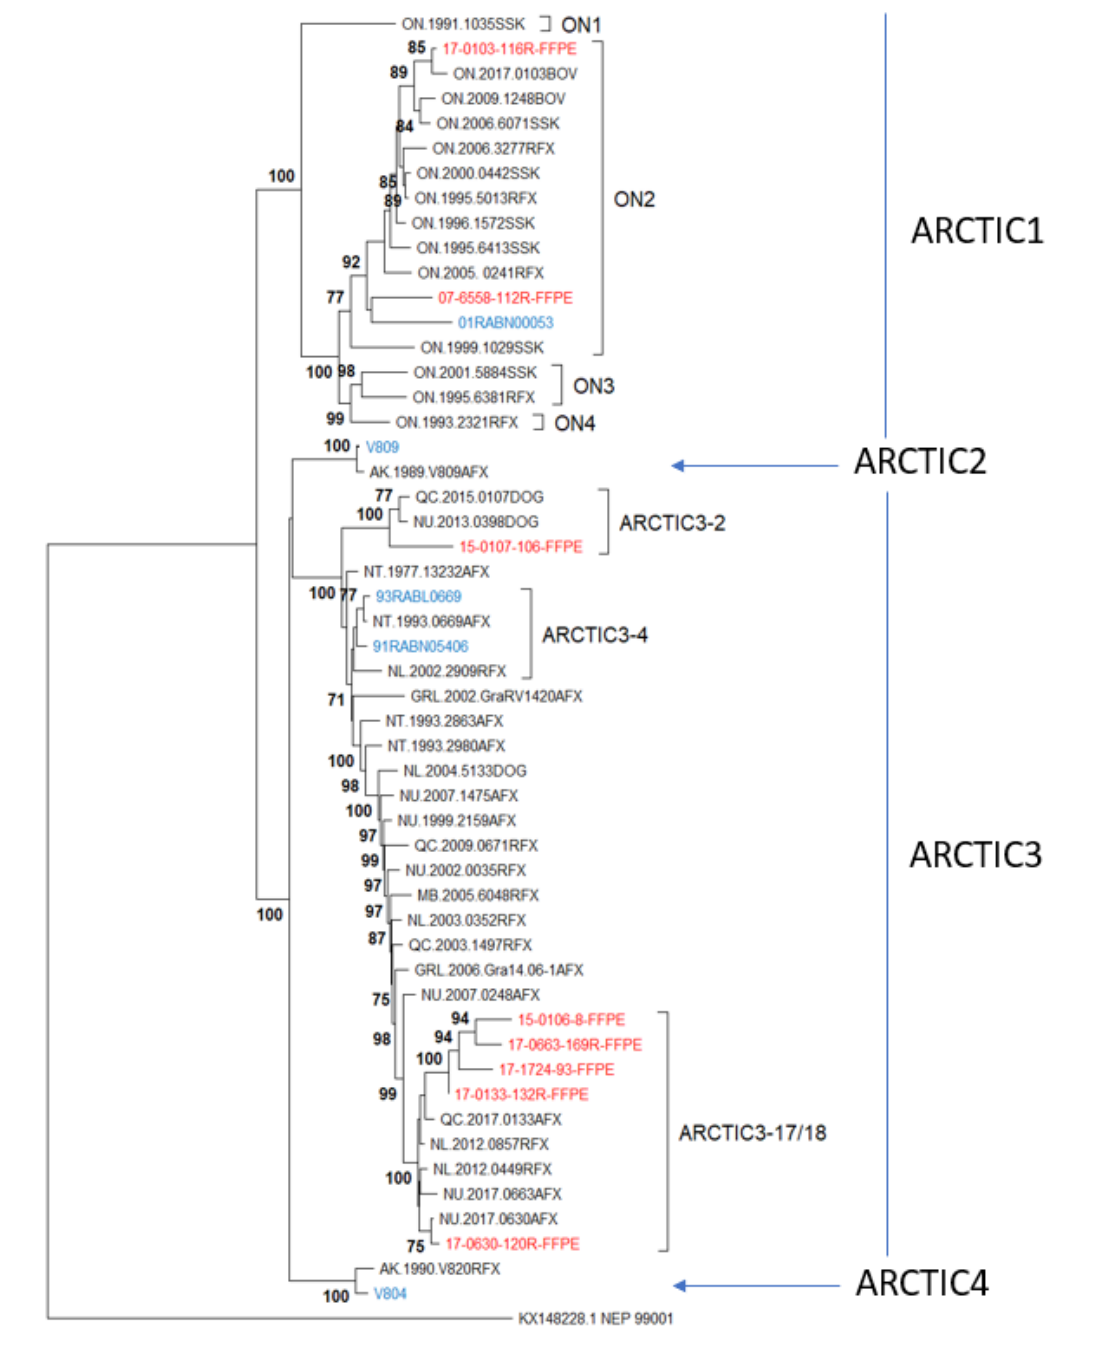
Figure 9. A Neighbor joining tree of 13 Ampliseq for Illumina samples and 39 RABVs representative of the Arctic lineage, as well as the Arctic-related outlier sample NEP99001 (AL3). The Ampliseq for Illumina samples were assembled using sample NT.1993.0669AFX (accession #MN233954) as a reference and then incorporated into the RABV whole genome alignment of the representative samples, details of which have been published [35,36]. The final dataset comprised 11,800 positions and was subject to phylogenetic analysis as described. Unfixed test samples are shown in blue and FFPE samples in red. Numbers at nodes indicate bootstrap values ≥ 70%. Clades are identified to the right of the